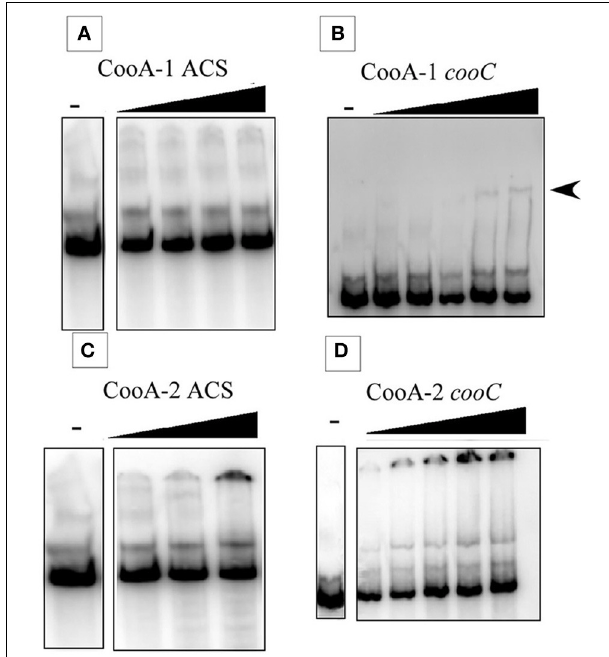
FIGURE 4 | Electrophoretic mobility shift assays at 25˚C. Gel shift results showing the binding of CooA-1 or CooA-2 to either p acs or the p cooC hyd promters from C. hydrogenoformans . Arrows indicate formation of the CooA-promoter complex. (A) CooA-1 binding to p acs (Protein added: 3, 6, 12, 18 μ g/ml). (B) CooA-1 binding to p cooC hyd (Protein added: 3, 6, 9, 12, 15 μ g/ml). (C) CooA-2 binding to p acs (Protein added: 3, 6, 9 μ g/ml). (D) CooA-2 binding to p cooC hyd (Protein added: 3, 6, 9, 12, 15 μ g/ml).